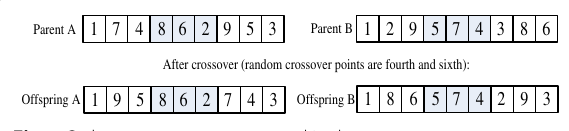
Fig. 7 Order crossover operator used in the segment gene material, and the corresponding swath from the other par- ent is sprinkled around in the child. Once this is done, the remaining alleles are copied directly from parent B, as shown in Fig. 8.